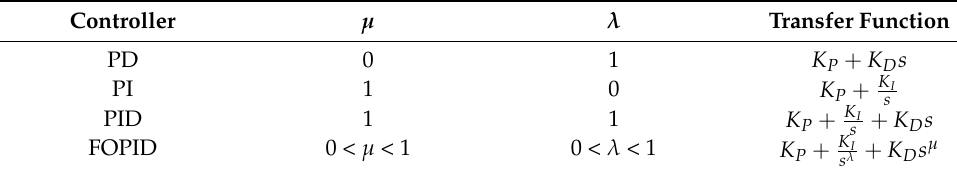
Table 4. Comparison of PD, PI, PID, and FOPID controllers’ tunable parameters.